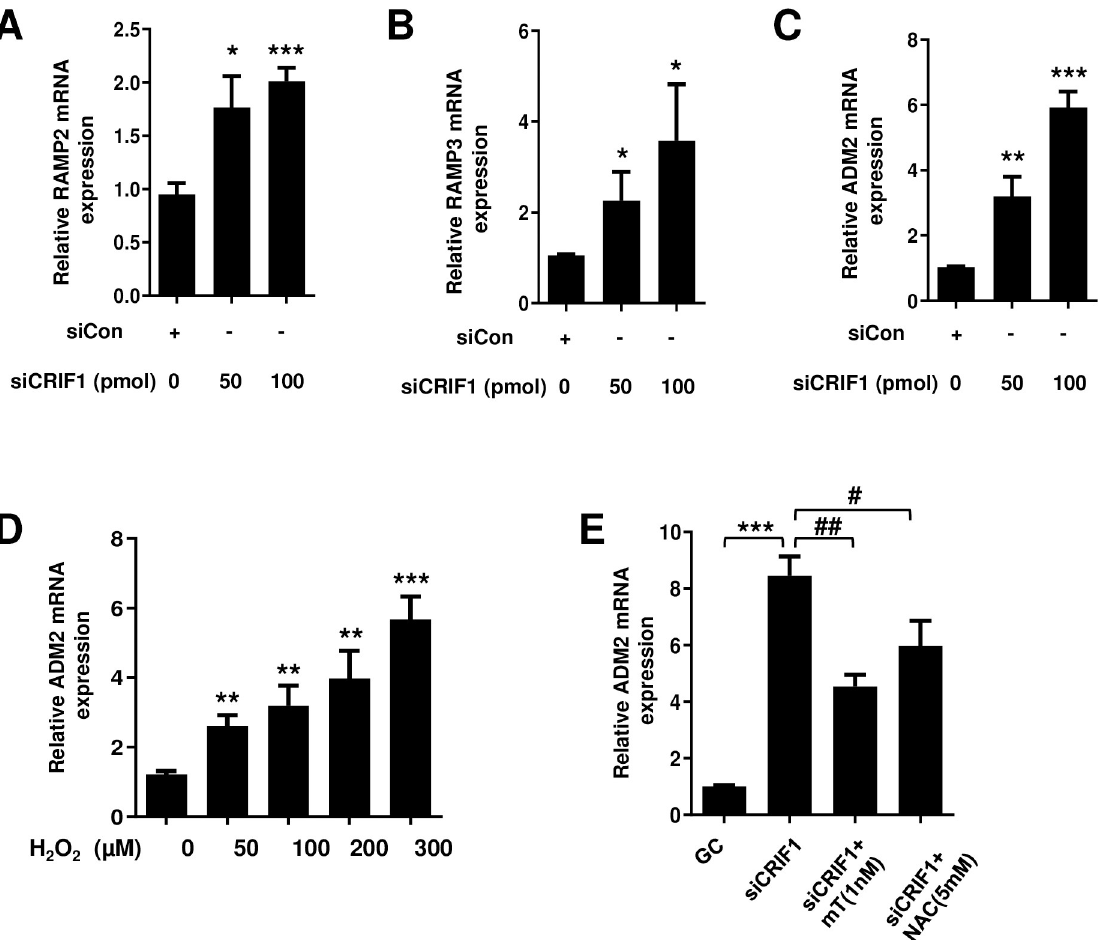
Fig 3. Effect of CRIF1 deficiency on the mRNA levels of RAMPs and endogenous ADM2 in endothelial cells. HUVECs were transfected with CRIF1 siRNA for 48 h. Next, the mRNA levels of (A) RAMP2 (B) RAMP3 and (C) ADM2 were determined by qPCR. (D) HUVECs were treated with the indicated doses of H 2 O 2 for 24 h followed by the detection of ADM2 mRNA levels (E) HUVECs were pretreated with the antioxidants MitoTEMPO (1 nM) and NAC (5 mM) for 1 h followed by transfection with control or CRIF1 siRNA (100 pmol) for 48 h. mRNA levels of ADM2 were determined by qPCR. Data are means ± SD of three independent experiments. � P < 0.05, �� P < 0.01 and ��� P < 0.001 relative to the control, # P < 0.05 and ## P < 0.01 relative to siCRIF1 (n = 3 per